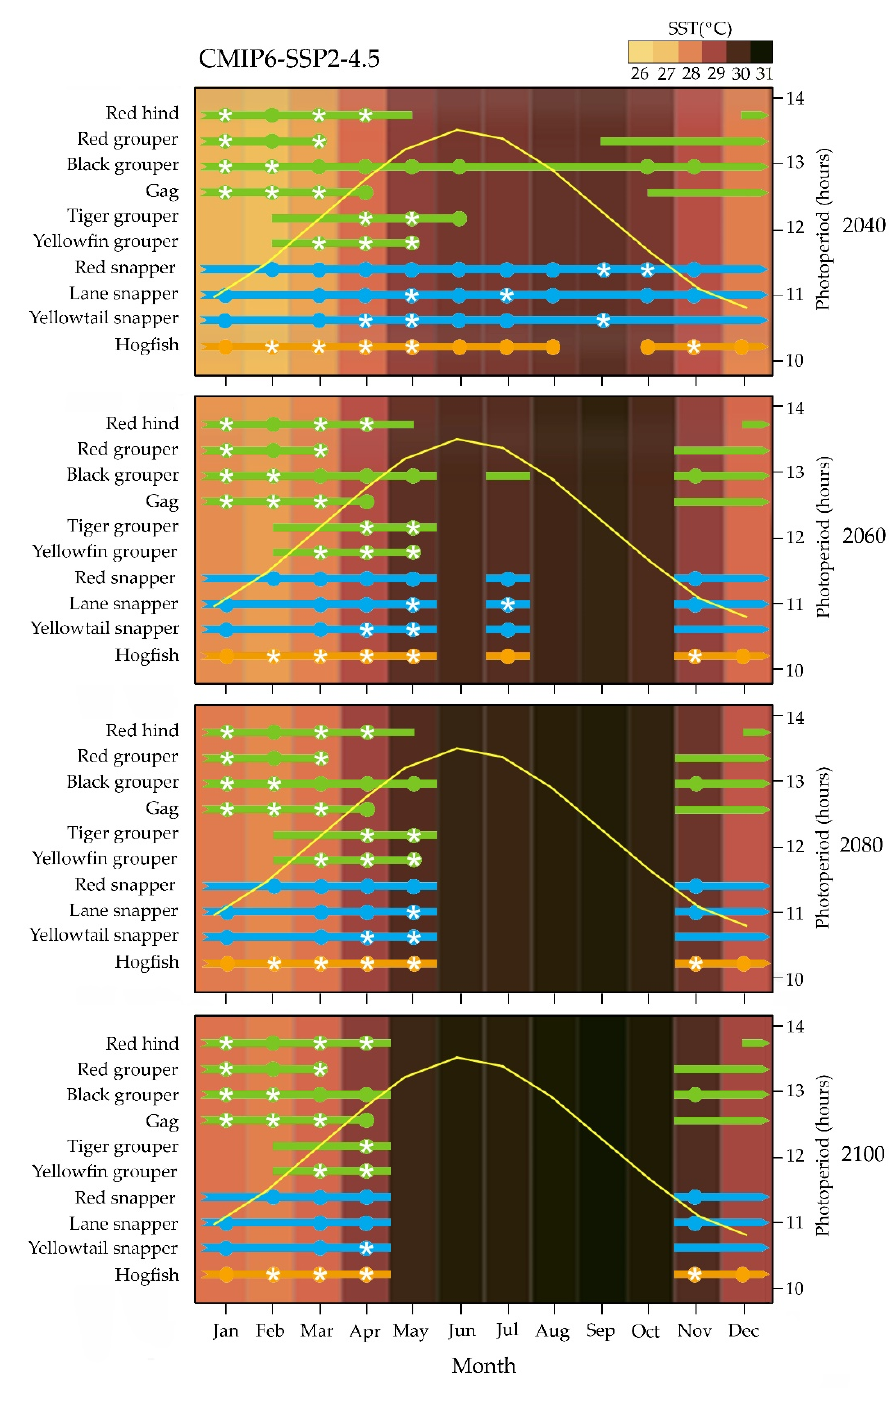
Figure 2. Hypothetical effect of climate change on reproductive cycle of studied grouper (green bars), snapper (blue bars), and wrasse (orange bars) species from the Campeche Bank, in relation to 2040, 2060, 2080, and 2100 monthly changes in mean sea surface water temperature (SST) predicted by the CMIP6 SSP2-4.5 scenario of the Intergovernmental Panel on Climate change [46–48]. For each species, solid bars represent reproductive season reported as the months that include spawning capable females; solid circles represent spawning season reported as the months that include actively spawning females, and white stars represent peak spawning reported as the months that include more than 50% of females in actively spawning sub phase (for reproductive phase terminology see [49]). Yellow curve indicates monthly photoperiod length (Time and Date AS 1995–2022. Available online: http://www.timeanddate.com/sun/mexico/merida, accessed on 1 March